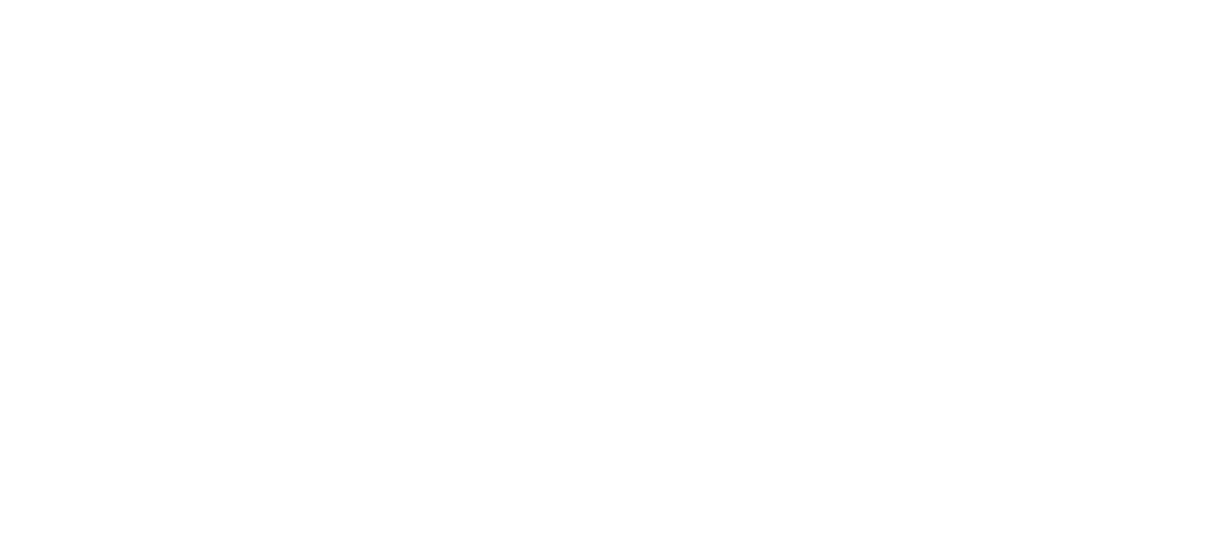
Figure A2 | representative selection of images from the database with embedded target